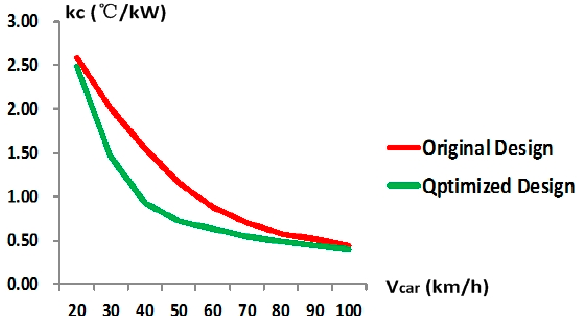
Figure 29. Condenser coupling factor optimization.